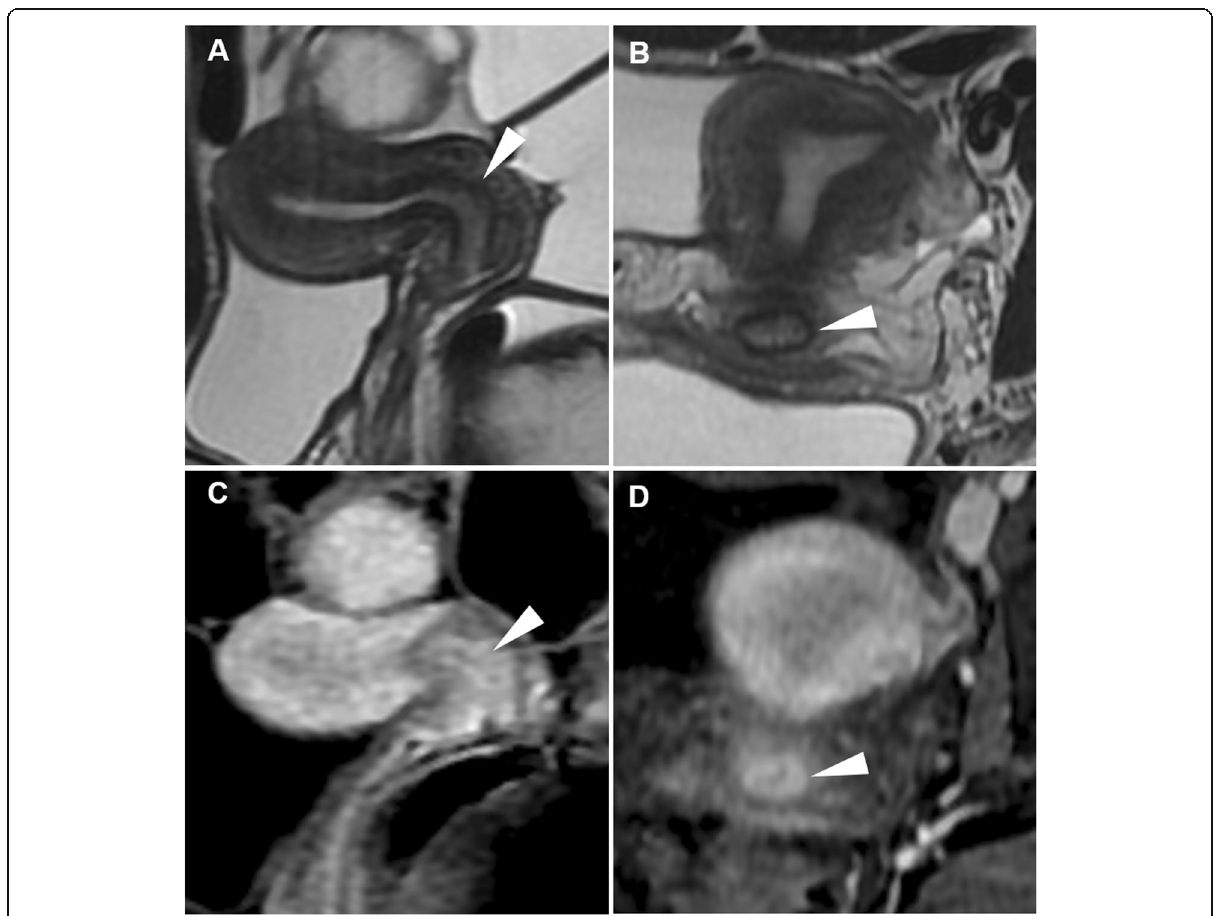
Fig. 9 Cervicitis in a 24-year-old woman suffering from pelvic pain. Sagittal ( a ) and oblique-coronal ( b ) T2-weighted images show thickening of the mucosal layer at the cervical canal (arrowheads). The corresponding post-gadolinium sagittal ( c ) and oblique-coronal ( d ) fat-suppressed T1- weighted images show prominent enhancement along the cervical canal (arrowheads)